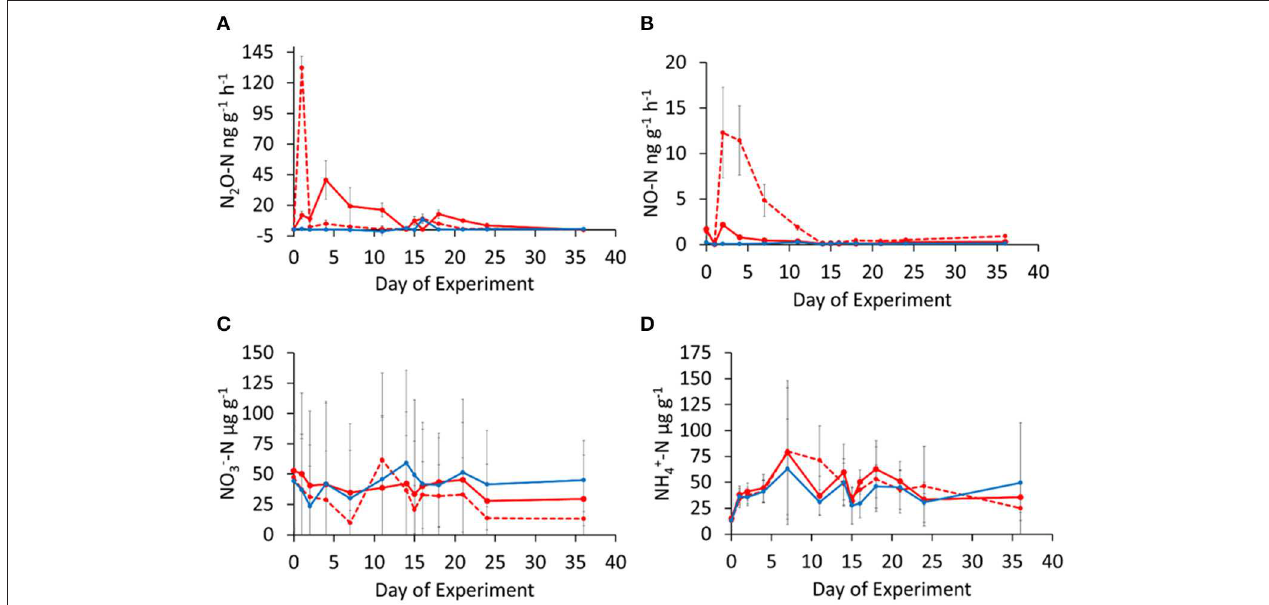
FIGURE 2 | Temporal changes in N 2 O (A) and NO (B) emission rates and soil NO − 3 (C) and NH + 4 (D) concentrations in oil palm (OP2: solid red circles, solid red line and OP7: solid red circles, dashed red line) and riparian reserve (RR: solid blue circles, solid blue line) soils. Error bars represent standard deviation of means from triplicate incubations. Soils were rewetted at day-0 with N supply at 5kg N ha − 1 equivalent to field N deposition condition, and at day-14 with NH 4 NO 3 amendment at 50kg N ha − 1 simulating a field N fertilization.